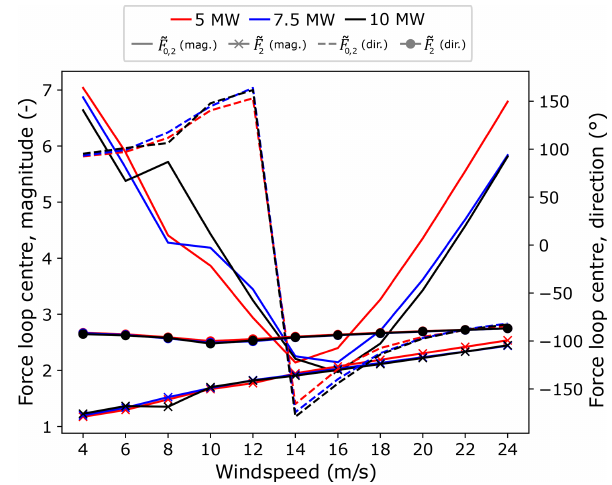
Figure 7. Non-dimensionalised, downwind row radial force-loop- centre magnitude and direction values for overhung ( ˜ F 0 , 2 ) and cen- tred ( ˜ F 2 ) main-bearing configurations across the three modelled tur- bines as the reference height wind speed is